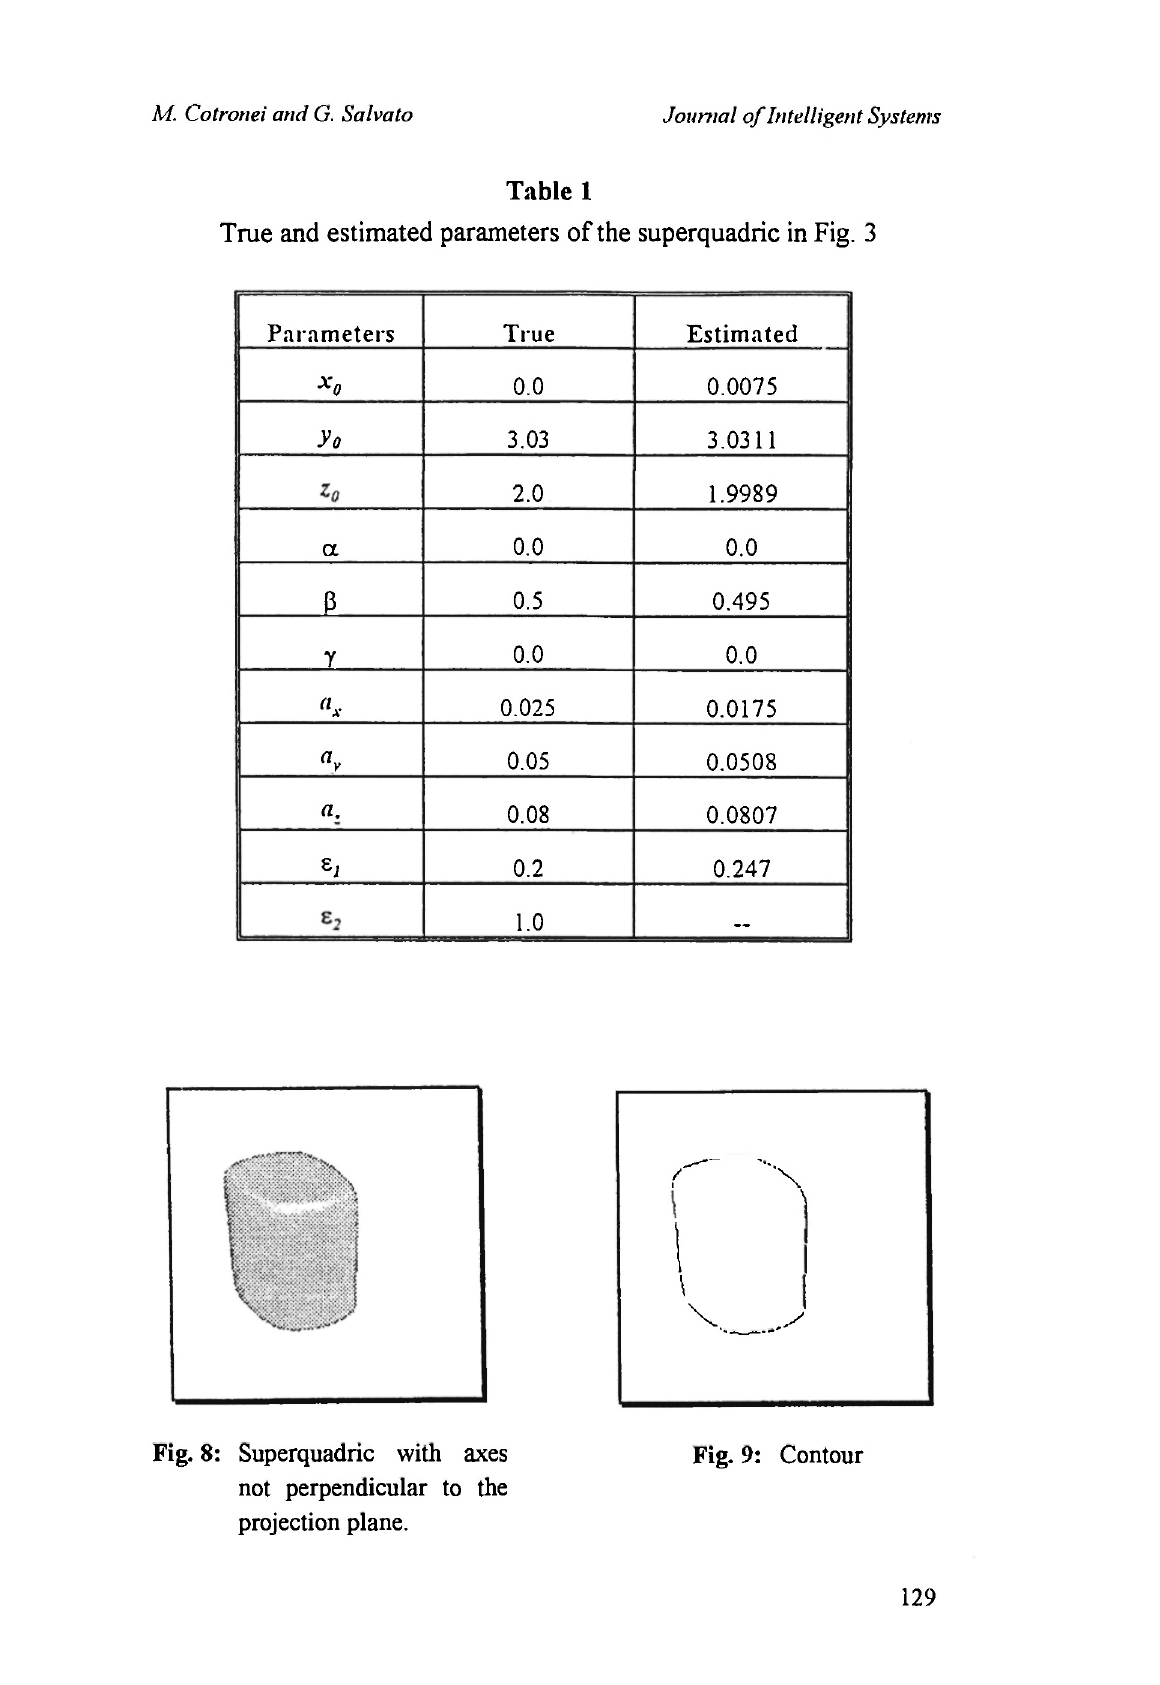
True and estimated parameters of the superquadric in Fig. 3